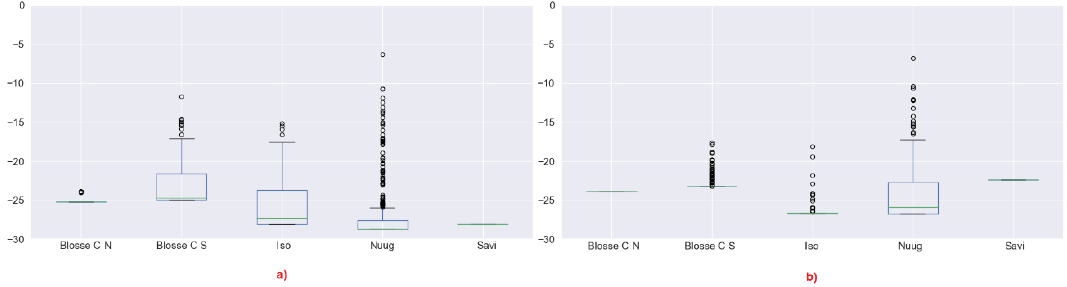
Figure 21. ( a ) Iceberg helix scattering boxplot 5 × 5 window, ( b ) 11 × 11 window. There are significant changes in helix scattering in Blosseville Coast S, Isortoq and Nuugaatsiaq.